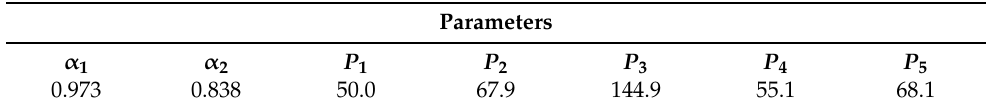
Table 1. The parameters of the proposed